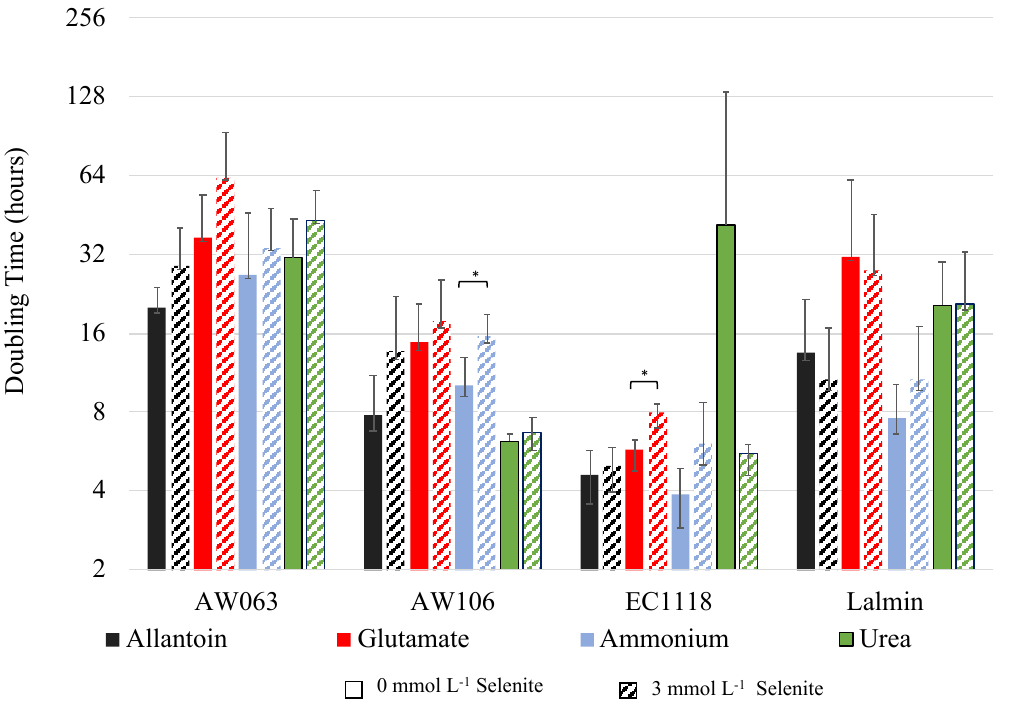
Figure 5. Dependence on the nitrogen source of selenium resistance. Strains were grown overnight in Synthetic complete medium then inoculated into medium containing equal nitrogen molar concentrations of the above compounds. The doubling time of strains inoculated into 3 mmol L −1 selenite containing medium is indicated by dotted columns. Their growth rate was monitored for 48 h, and maximal growth rate (doubling time) was determined as described in methods. Doubling times are displayed on a logarithmic scale. Bar with asterisk indicates a significant difference ( p < 0.05) in doubling time between 0 and 3 mmol L −1 conditions.